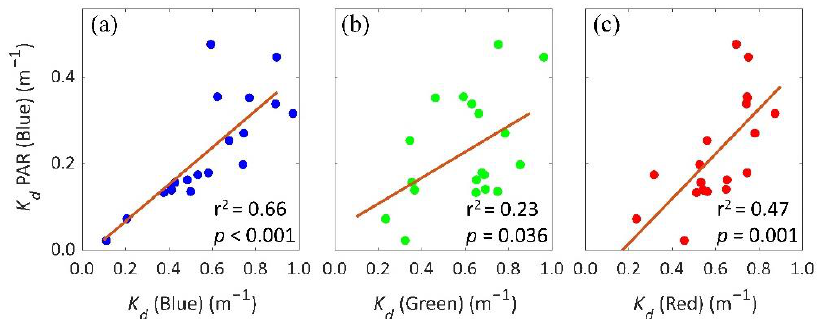
Figure 14. The correlations between K d (Blue) ( a ), K d (Green) ( b ), K d (Red) ( c ) derived from the spatial method (tile size: 60 m) and K d (PAR) with the r 2 values of 0.66, 0.23 and 0.47, respectively ( p < 0.05). K d (PAR) was measured in situ (Flowers et al. in prep.) on 26 February and 12 March 2020, coinciding with a Sentinel-2 overpass.